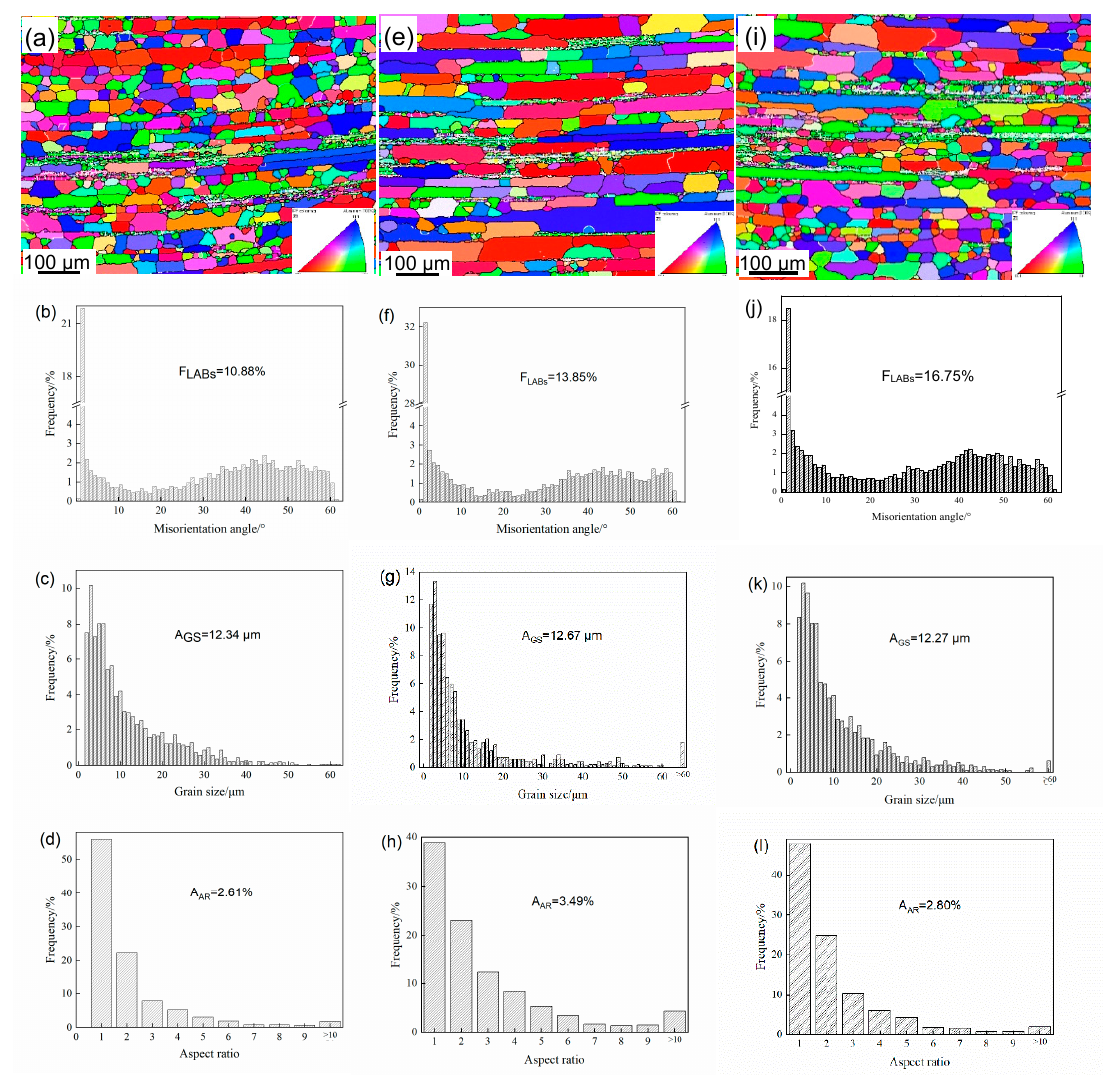
Figure 6. Electron backscattered di ff raction (EBSD) images of solutionized 2195 Al-Li alloy sheets after annealing at 300 ◦ C prior to solution. ( a ) Inverse pole figure (IPF) maps; ( b ) misorientation angle distribution; ( c ) grain size distribution; ( d ) grain aspect ratio distribution; and the solutionized 2195 Al-Li alloy sheets after annealing at 300 ◦ C prior to solution. ( e ) IPF maps; ( f ) misorientation angle distribution; ( g ) grain size distribution; ( h ) grain aspect ratio distribution; and the solutionized 2195 Al-Li alloy sheets after annealing at 400 ◦ C prior to solution. ( i ) IPF maps; ( j ) misorientation angle distribution; ( k ) grain size distribution; and ( l ) grain aspect ratio distribution.